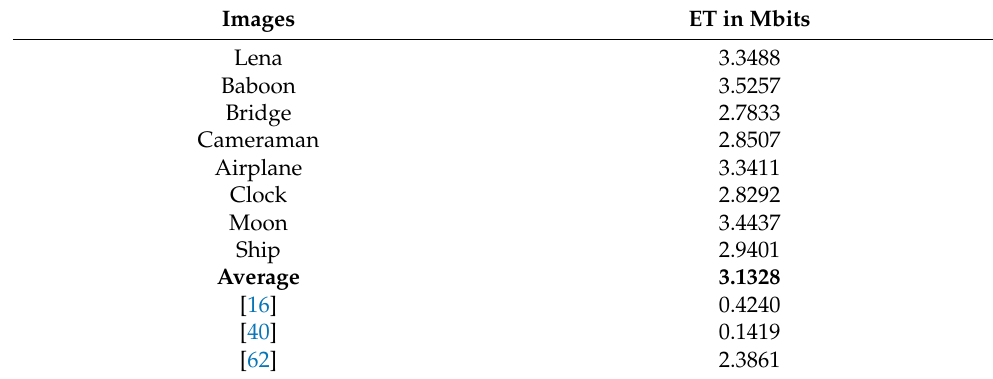
Table 8. Suggested scheme’s encryption throughout and a comparative analysis with other